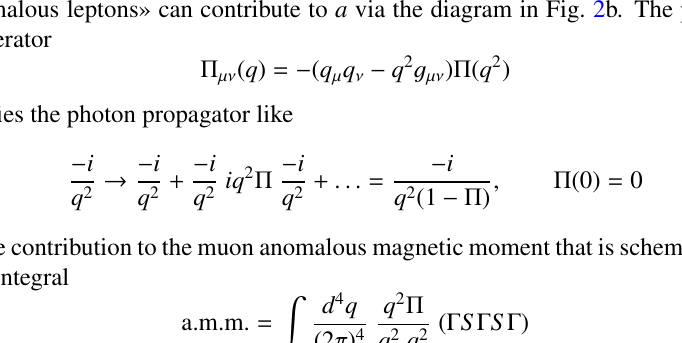
«Anomalous leptons» can contribute to a via the diagram in Fig. 2b. The photon